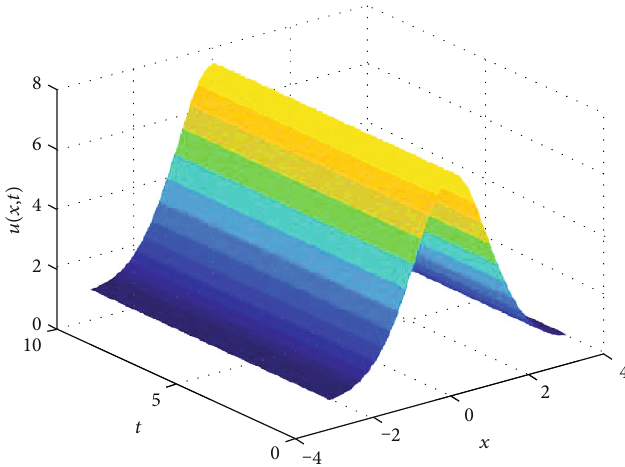
Figure 3: The approximate solution on the region ½ 0, 10 (cid:2) × ½ − π , π (cid:2) for Example